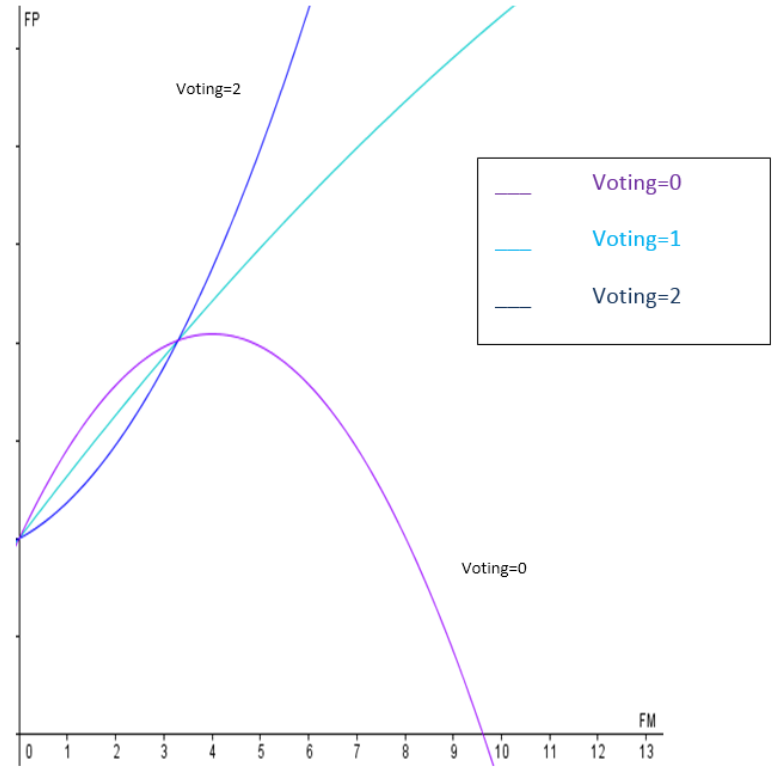
Figure 2. Significant Interactions between Family Management and Voting Provision. The negative moderation effects of Voting Provision changes the direction of inverted U-shaped relationship between Family Management and Firm Performance into a